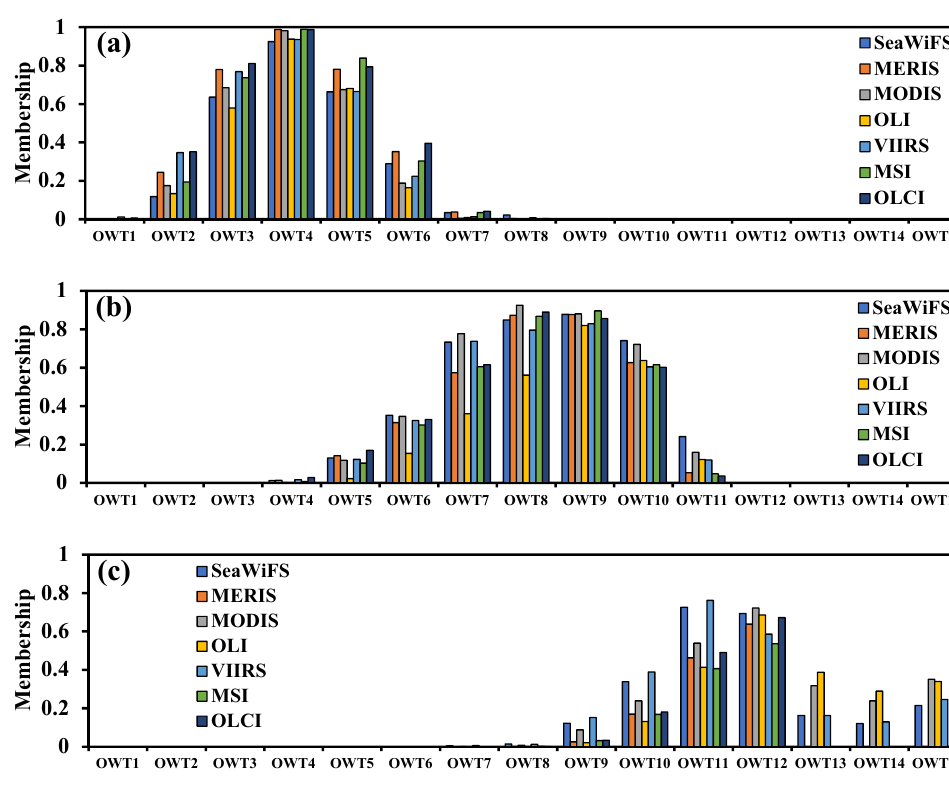
Figure 6. The U-OWT average memberships of the IOCCG synthetic R rs ( λ ) for different water trophic states: ( a ) 25 R rs ( λ ) spectra with Chla = 0.3 μ g/L (oligotrophic), ( b ) 25 R rs ( λ ) spectra with Chla = 3 μ g/L (mesotrophic), and ( c ) 25 R rs ( λ ) spectra with Chla = 30 μ g/L (eutrophic).